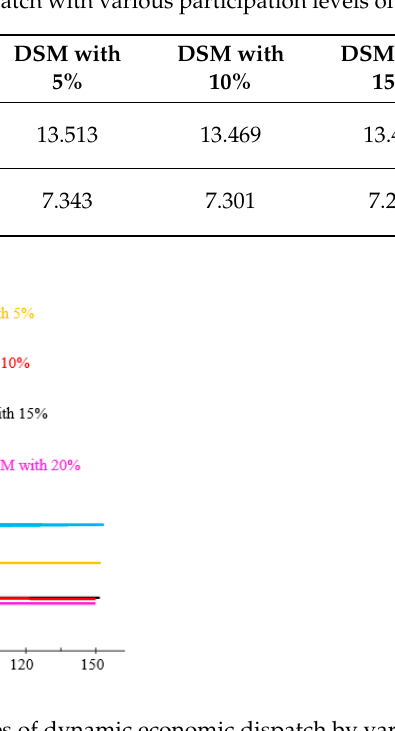
Figure 6. Frugality of public industry energy bill ( a ) and decline of peak load ( b ) by various levels of DSM participation.